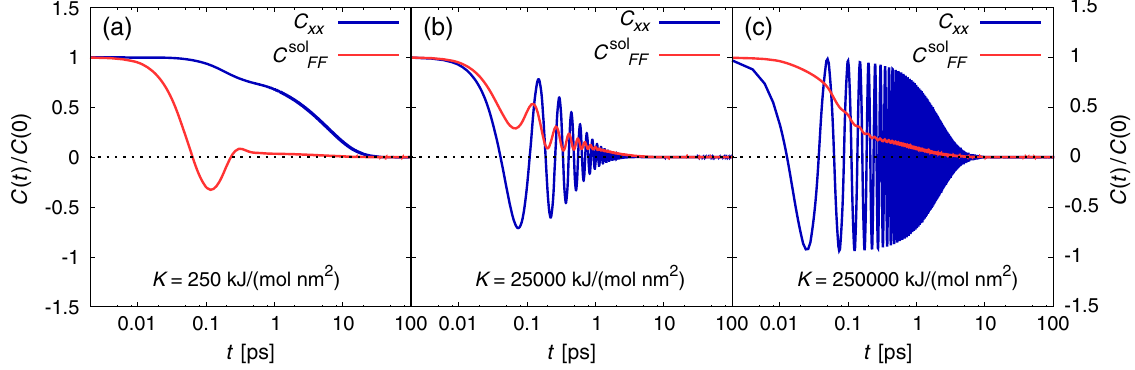
ð t Þ =C ð 0 Þ (blue) and normalized solvent force autocorrelation function xx xx